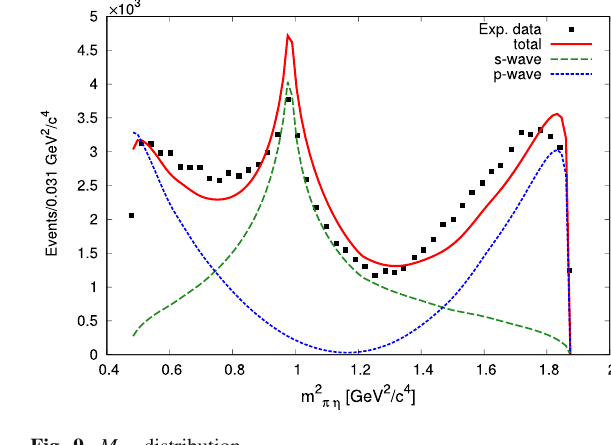
Fig. 9 M πη distribution